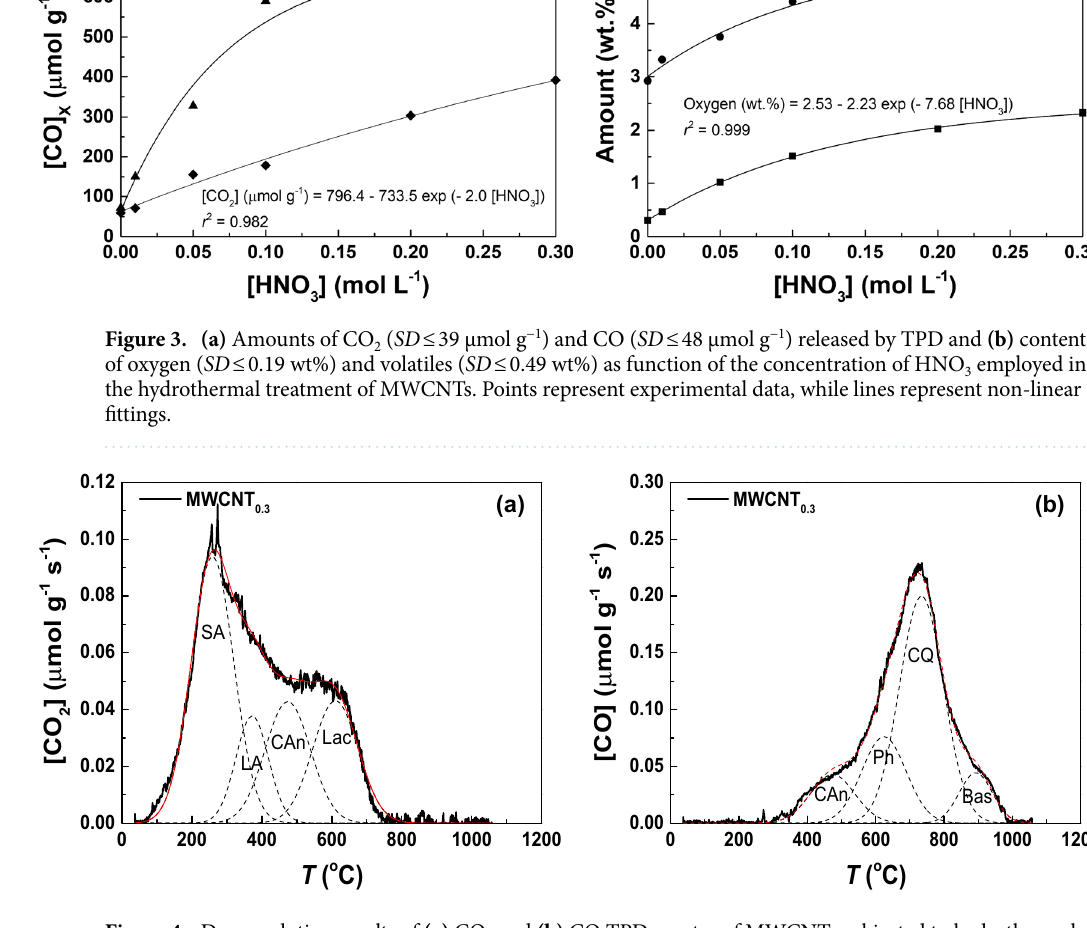
Figure 4. Deconvolution results of (a) CO 2 and (b) CO TPD spectra of MWCNTs subjected to hydrothermal treatment with 0.30 mol L −1 HNO 3 (MWCNT 0.3 ). Dashed lines represent peaks assigned to strongly acidic carboxylic acids (SA), less acidic carboxylic acids (LA), carboxylic anhydrides (CAn), lactones (Lac), phenols (Ph), carbonyls and quinones (CQ) and basic surface groups (Bas), such as pyrones and chromenes. Red lines represent cumulative peak